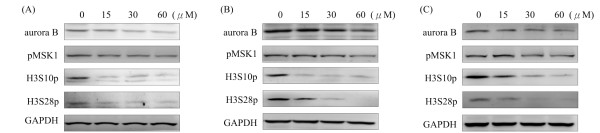
Downregulation of aurora B, pMSK1, H3S10p, and H3S28p protein expression levels was observed with squamocin treatment. Cells were incubated with 15, 30, and 60 μM squamocin for 24 h. Proteins were extracted and analyzed by Western blotting. GAPDH was used as a loading control. (A) GBM841 cells. (B) Huh-7 cells. (C) SW620 cells. Data are representative of three independent experiments.